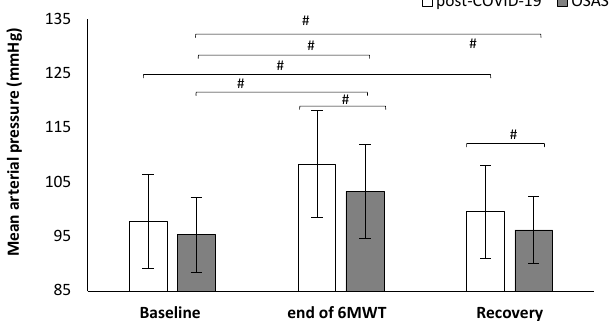
Figure 2. Mean arterial pressure alteration during the 6-minute walk test (6MWT) between the groups. # < 0.005.